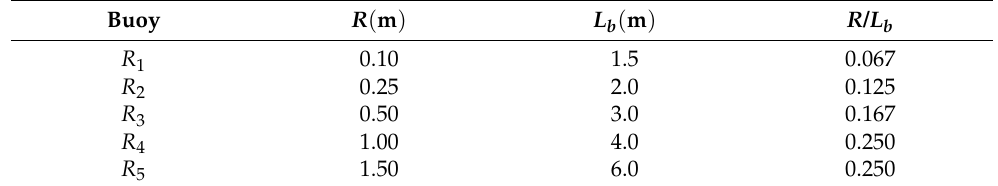
Table 2. Tested values for the buoy’s radius ® and its arm length ( L b ).